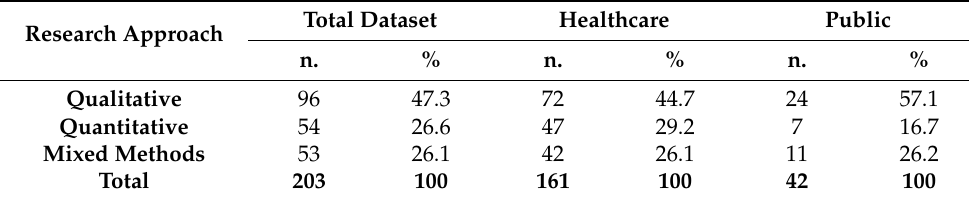
Table 3. Research approach of reviewed articles.